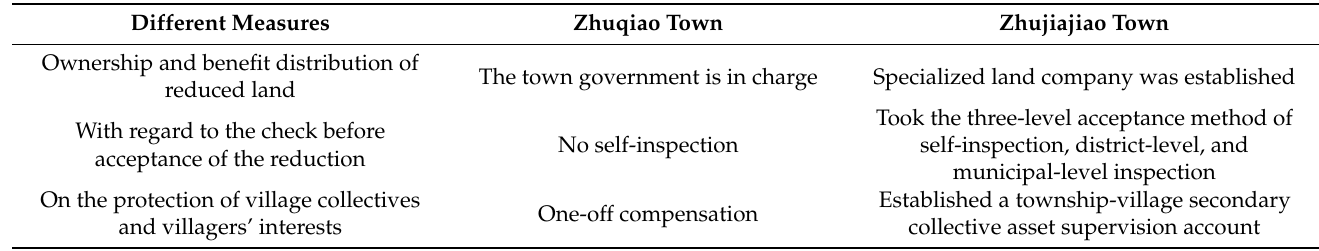
Table 2. Comparison of the practices between Zhuqiao Town and Zhujiajiao